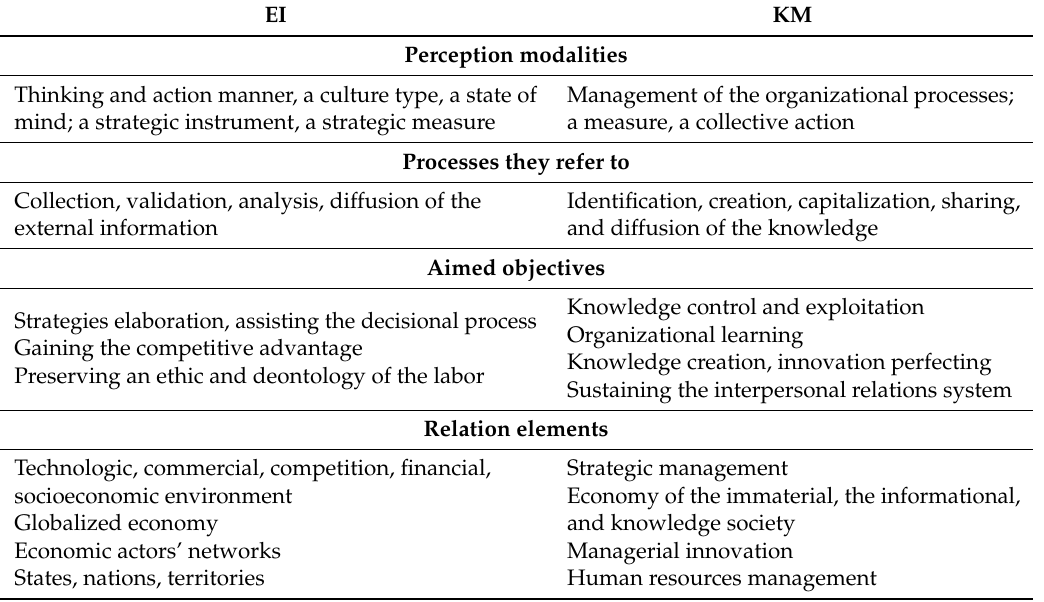
Table 1. Complementarities between economic intelligence (EI) and knowledge management